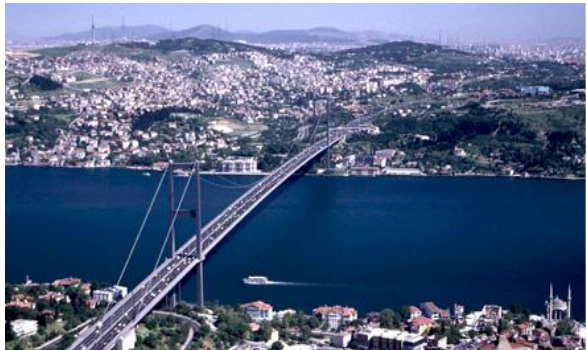
Figure 1. Üsküdar from the Europa side of Istanbul (http://www.garantitatil.com/istanbul-turu.html, 16 April 2012)